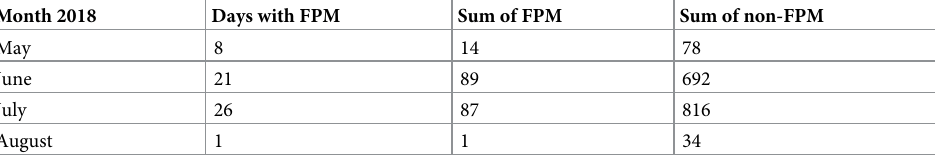
Table 3. Number of days with feeding positive minutes (FPM) per month, and sum of FPM and non-FPM (belu- gas detected but no feeding) for those days off Susitna Delta in Cook Inlet, AK, during the 2018 ice-free